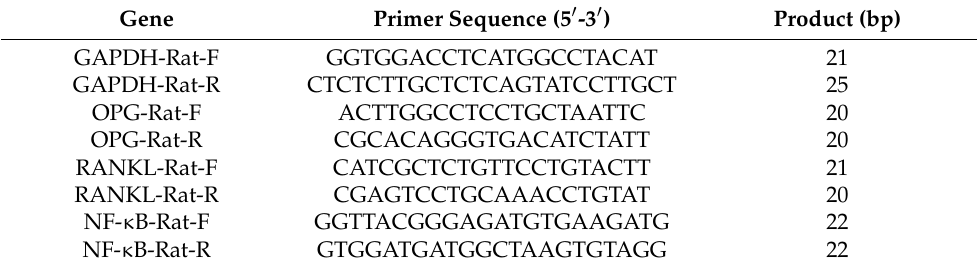
Table 2. The sequences of the